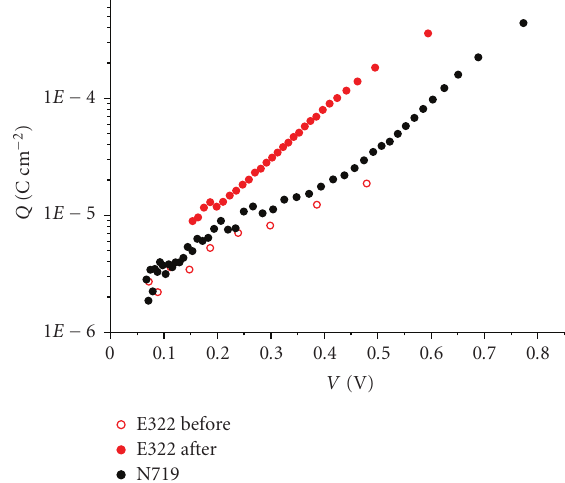
Figure 6: Extracted charge as a function of the open circuit photovoltage in dye-sensitized solar cell with E322 and N719. This measurement was carried out for the cell with E322 before and after employing the UV